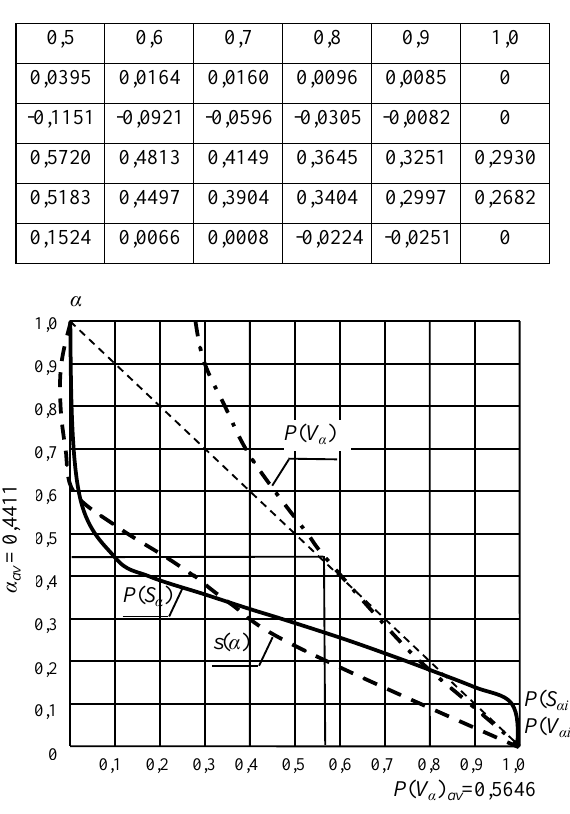
Table 3. Continuation